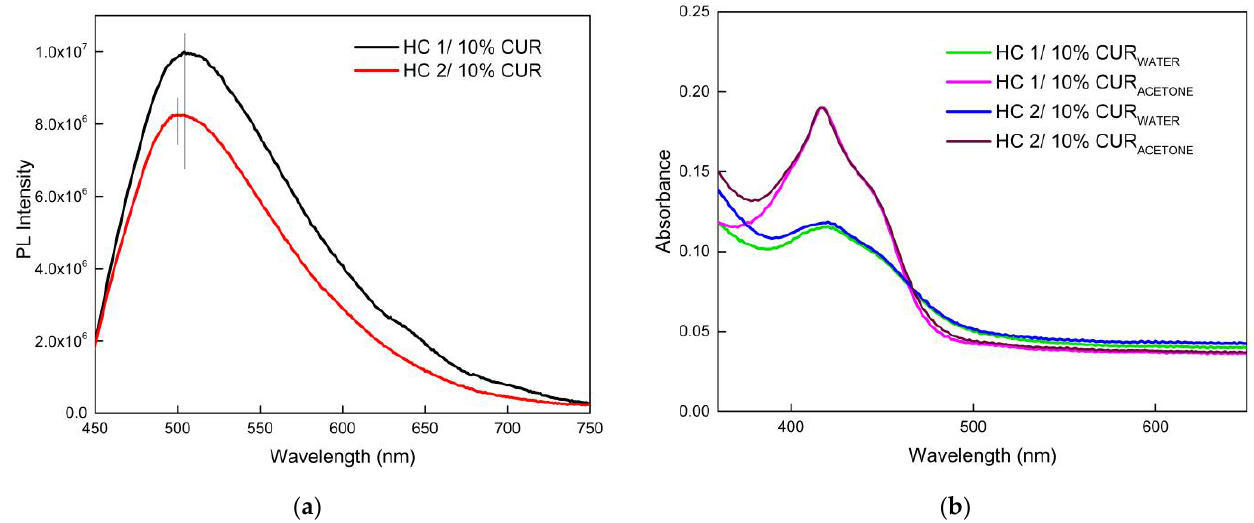
Figure 9. Fluorescence ( a ) and Uv-Vis ( b ) spectra of the CUR-loaded PNPs.